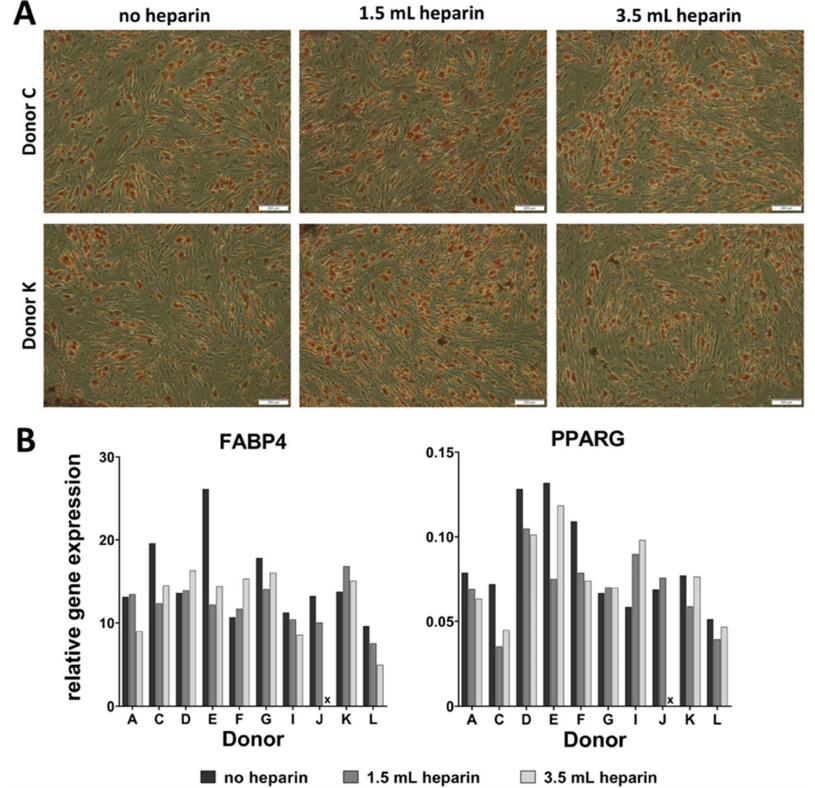
Figure 5. Adipogenesis in vitro. ( A ) Oil Red O-staining, microscopic views. Scale bar: 200 µ m. ( B ) Relative gene expression analysis (2 − ∆ Ct ) for adipogenic marker genes at day 14. x: available cell numbers were too low for inclusion in the